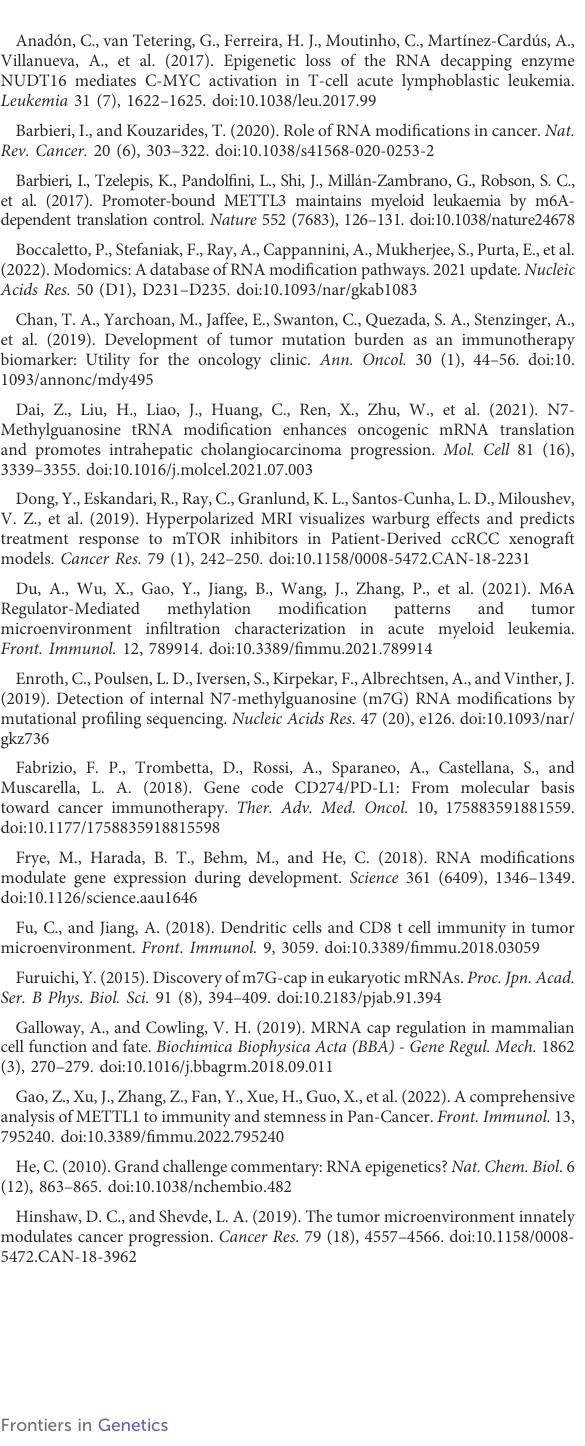
genes across 33 TCGA cancer types. (B) The forest map of DSS hazard ratio of 31 m7G-related genes across 33 TCGA cancer types. (C) Survival correlation analysis of m7G related regulators in DSS across multiple cancer types. (D) The correlation relationship among the expression of 31m7Gmethylationregulatorsandtumorpurity. (E) Correlation between the expression of 31 m7G methylation regulators and the stromal cell score. SUPPLEMENTARY FIGURE S3 Survival analysis of m7G related regulators across multiple cancer types. The red line in the photos indicates high expression and the blue line in the photos indicates low expression.